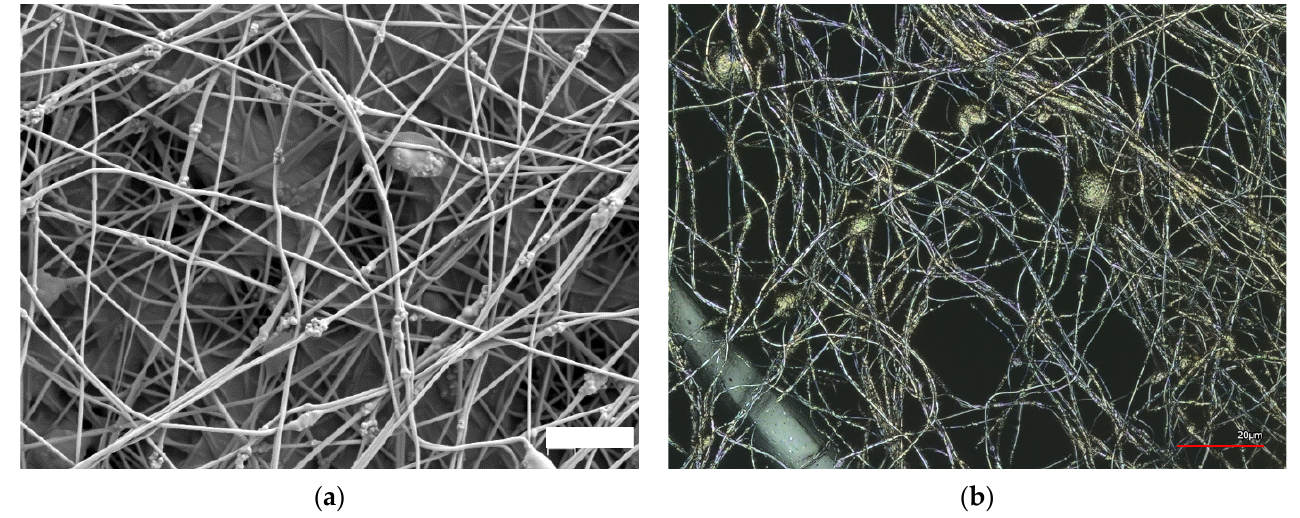
Figure 7. Scanning electron microscope (SEM) image showing an electrospun magnetic PAN nano fi ber mat with 20 wt% Fe 3 O 4 ( a ). Adapted from [42], originally published under a CC-BY license. Confocal laser scanning microscope image (CLSM) showing a PAN nano fi ber mat with 20 wt% Fe 3 O 4 ( b ).